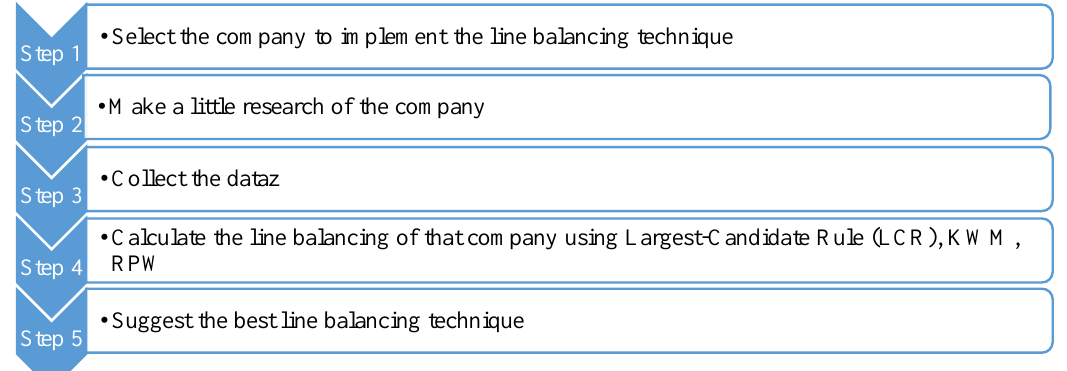
Figure 1. Visual representation of the procedures of whole research